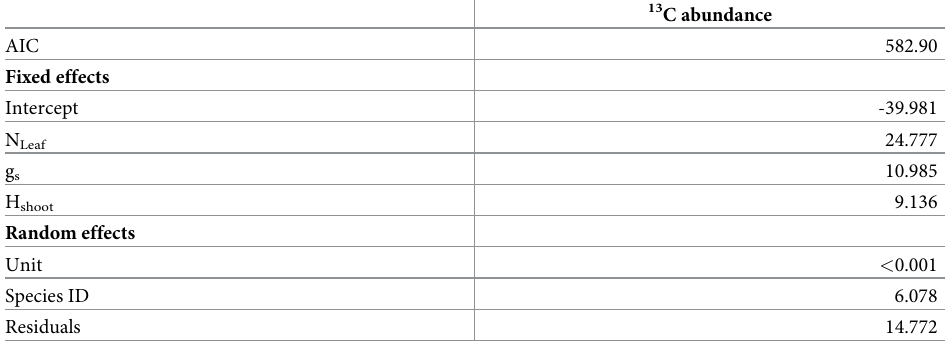
Table 1. Analysis of species-level 13 C abundances in shoot biomass. Shown is the summary of a mixed-effects model testing for relationships between species-level 13 C abundances in shoot biomass and plant traits.